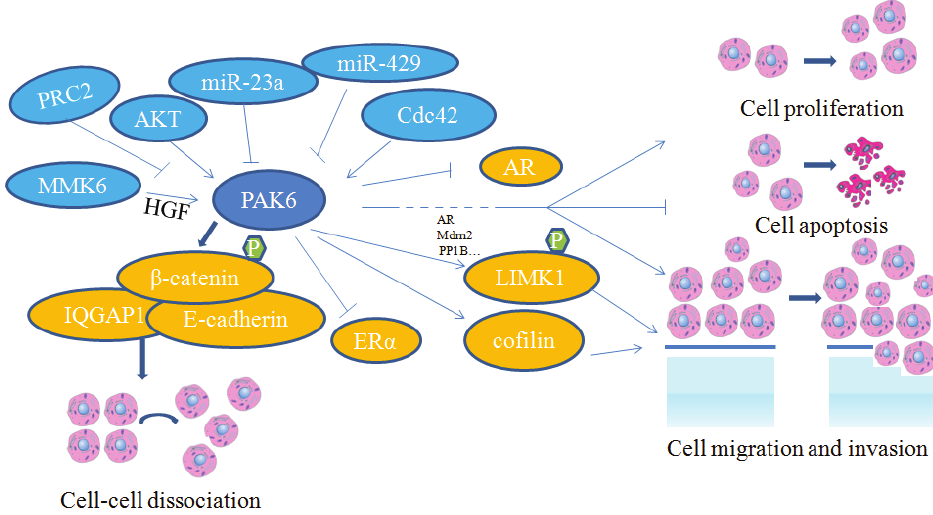
FIGURE 2 - The signal transduction cascade of PAK6 in